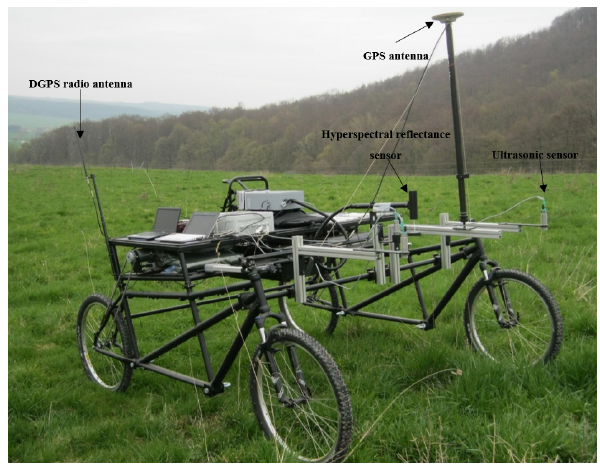
Figure 2. Remotely steered sensor vehicle with hyperspectral re- flectance, ultrasonic sensors and mounted GPS